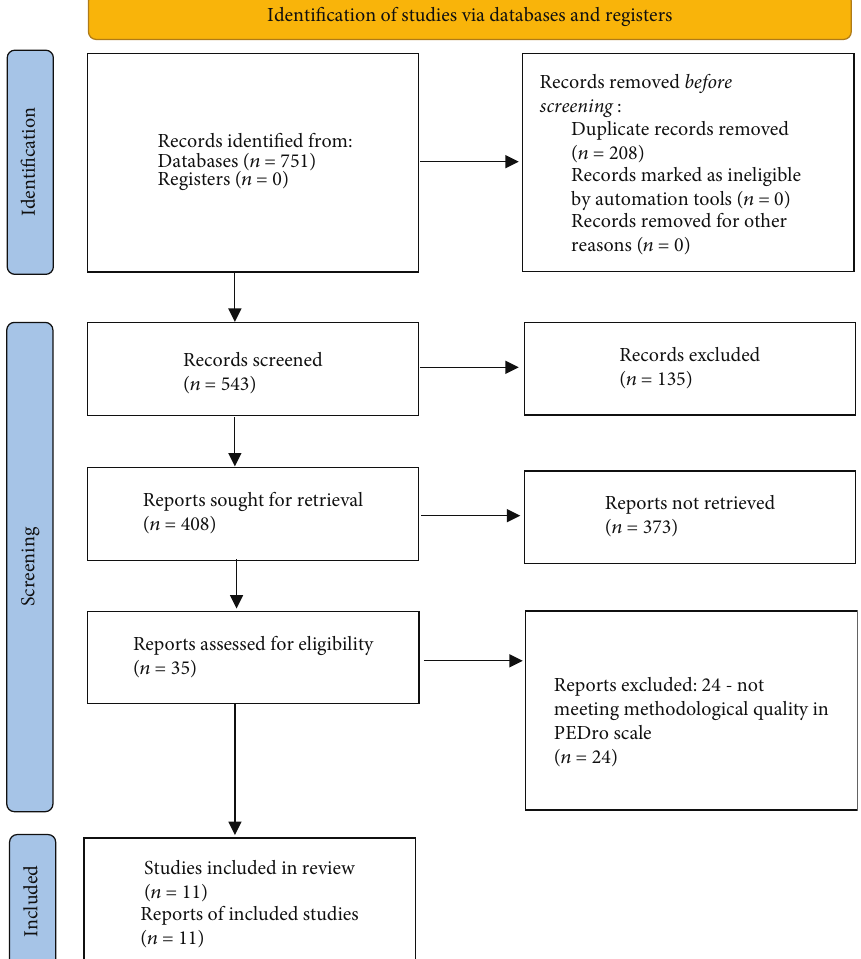
Figure 1: Result strategy fl